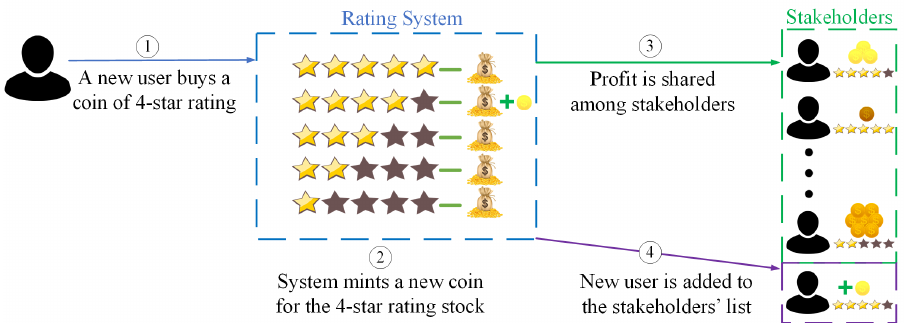
Figure 2. Buying a coin from the rating system. We used different colors to demonstrate the difference in coins of ratings’ stocks.